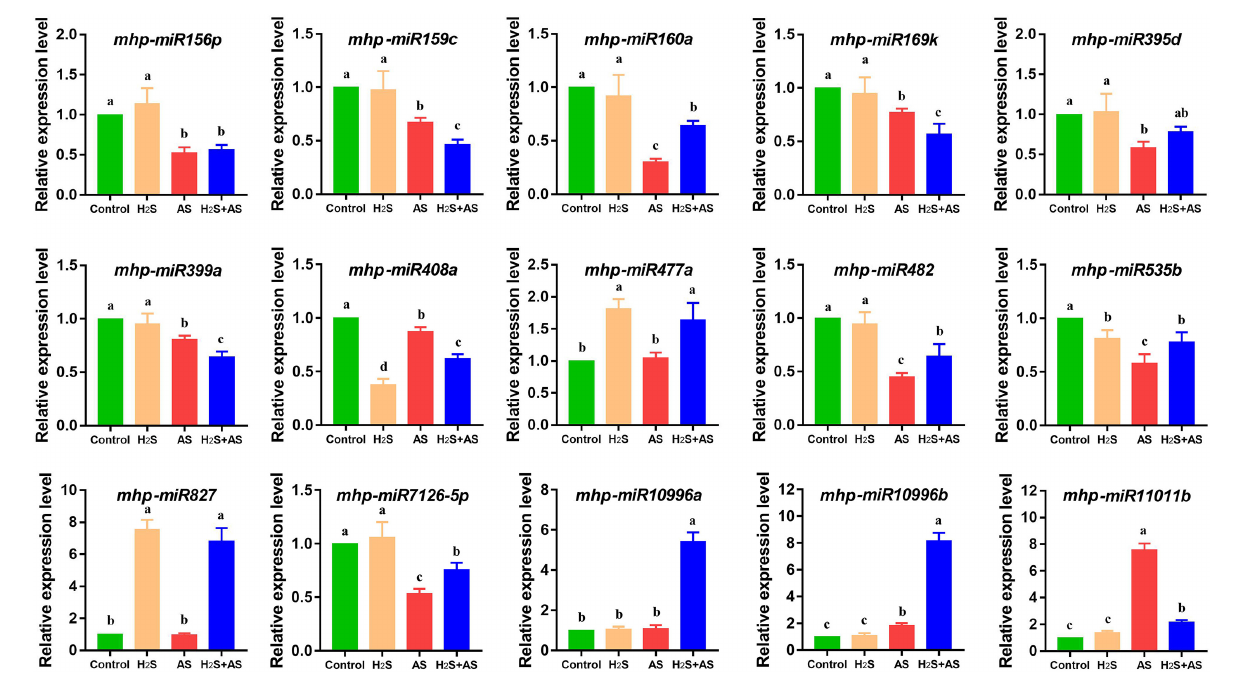
FIGURE 7 | qRT-PCR analysis of identified miRNAs in M. hupehensis roots under different treatments. Three biological replicates were conducted for each sample and three technical replicates. The relative expression level of different miRNAs was calculated by the 2 − (cid:49)(cid:49) CT method. U6 was used for normalizing miRNA expression. The expression levels were normalized to those of the control. The standard error (SE) values are represented by the error bar, and the significant differences ( P < 0.05) are indicated by different lowercase letters above each